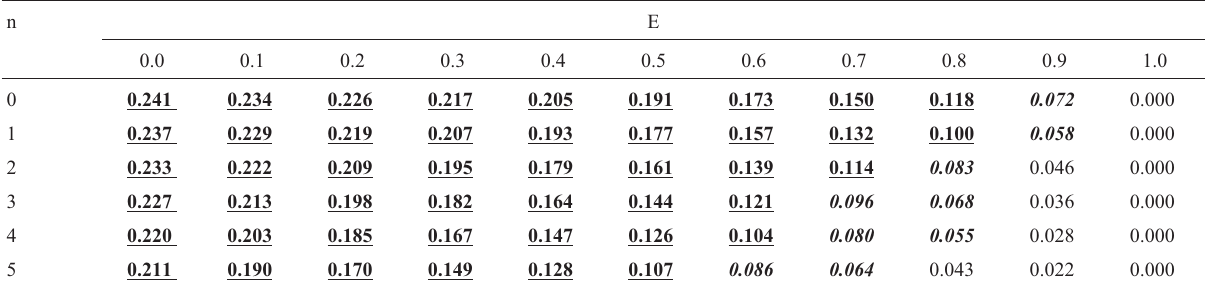
Table 6 - Recurrence risks for a sib of an isolated case, with consanguineous parents and F = 1/64 (second cousins), in function of the rate of environmental cases (E) and of the number of normal sibs (n = n m + n f ) that the affected child already has.